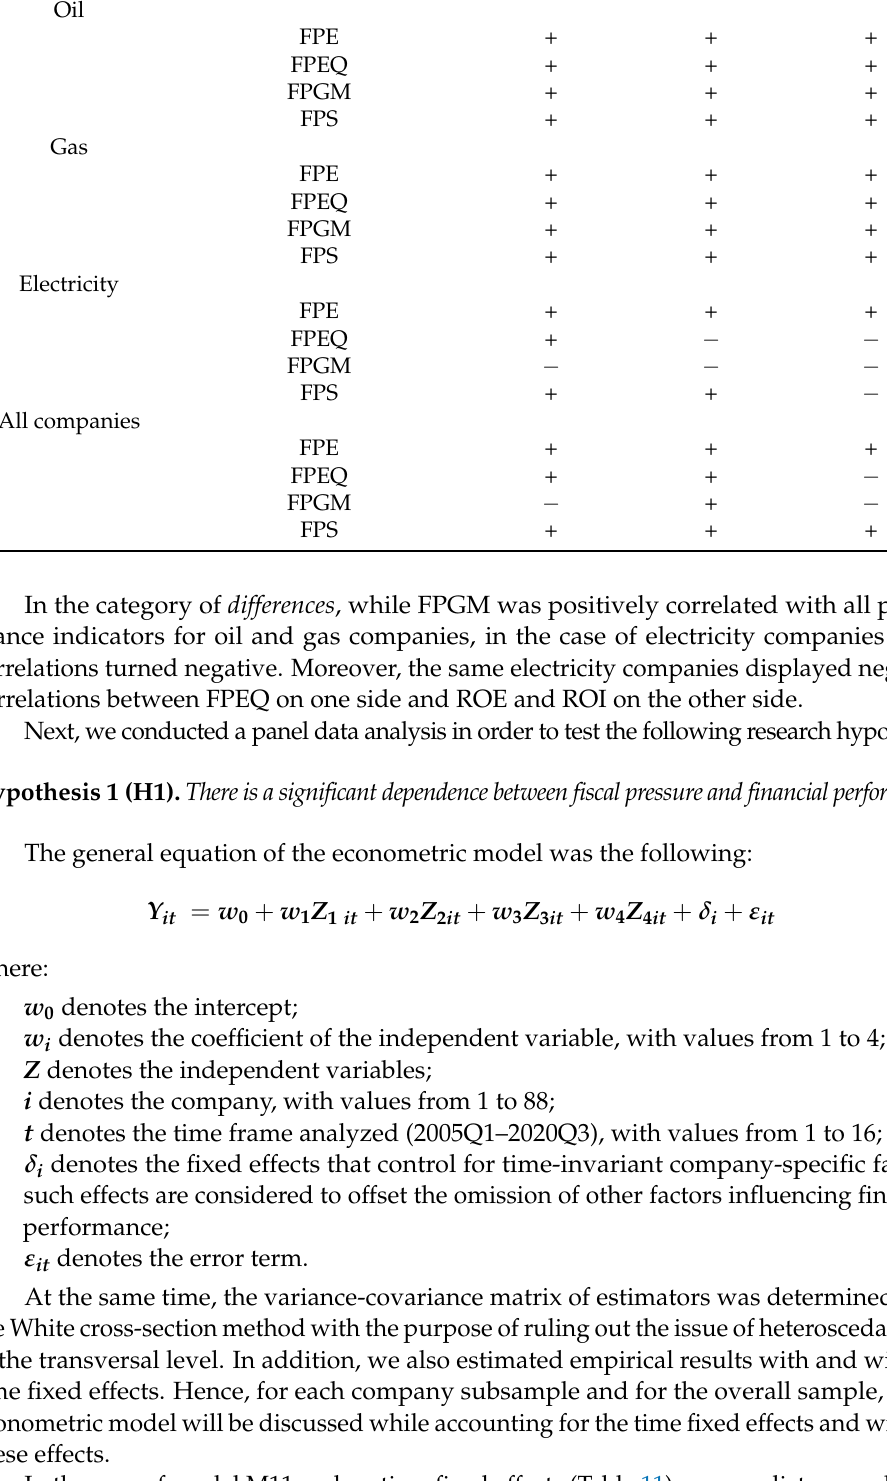
Table 10. The synthesis of correlation analyses for subsamples and overall sample. Companies Independent Variables ROA ROE ROI Oil